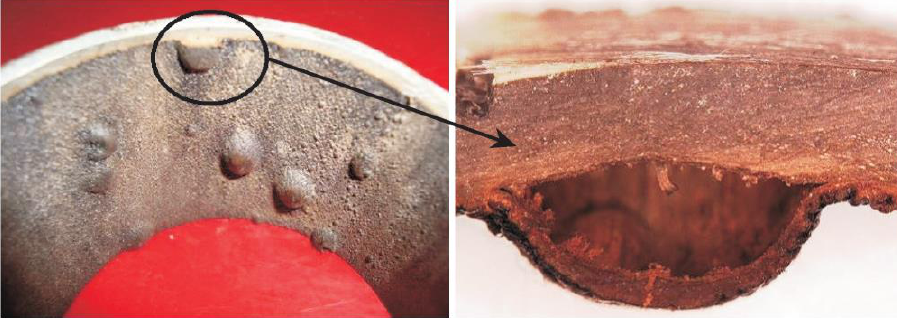
Figure 1. The blister failure of thermoplastic used in oilfield gathering and transportation. Over the past years, experimental methods based on manometric measurements were applied to study gas permeability, diffusion, and solubility in the onshore and off- shore petroleum industry. The gas permeation behavior of HDPE, which is the most used liner material of RTPs, was studied using the differential pressure method [9]. It was shown that the gas permeability coefficient of CO 2 and CH 4 at different temperatures through HDPE meets the Arrhenius equation. Flaconnèche et al. [10] applied the time lag method to obtain the transport coefficients of gases in PE, PA11 and PVF 2 . It has been found that the transport coefficients are independent of the membrane thickness. A con-